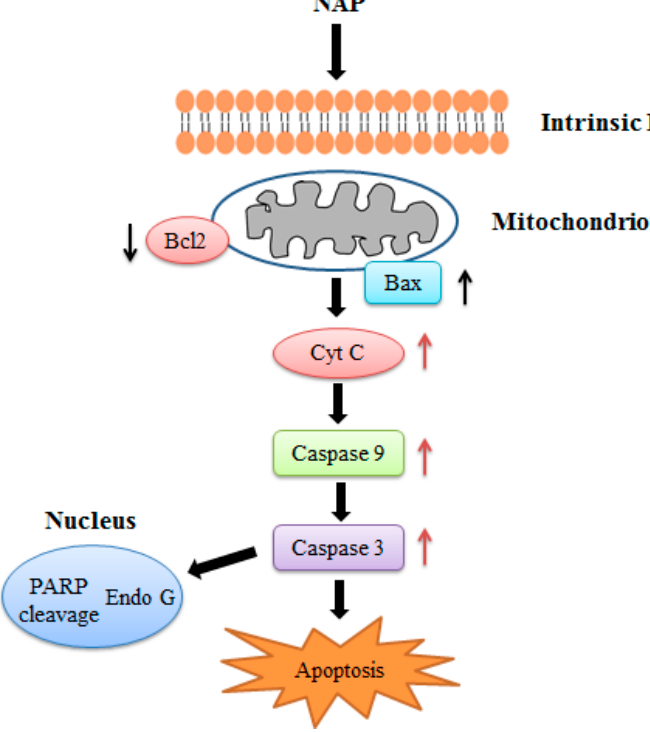
Figure 10. NAP induced apoptosis in the human lung cancer H1299 cells.